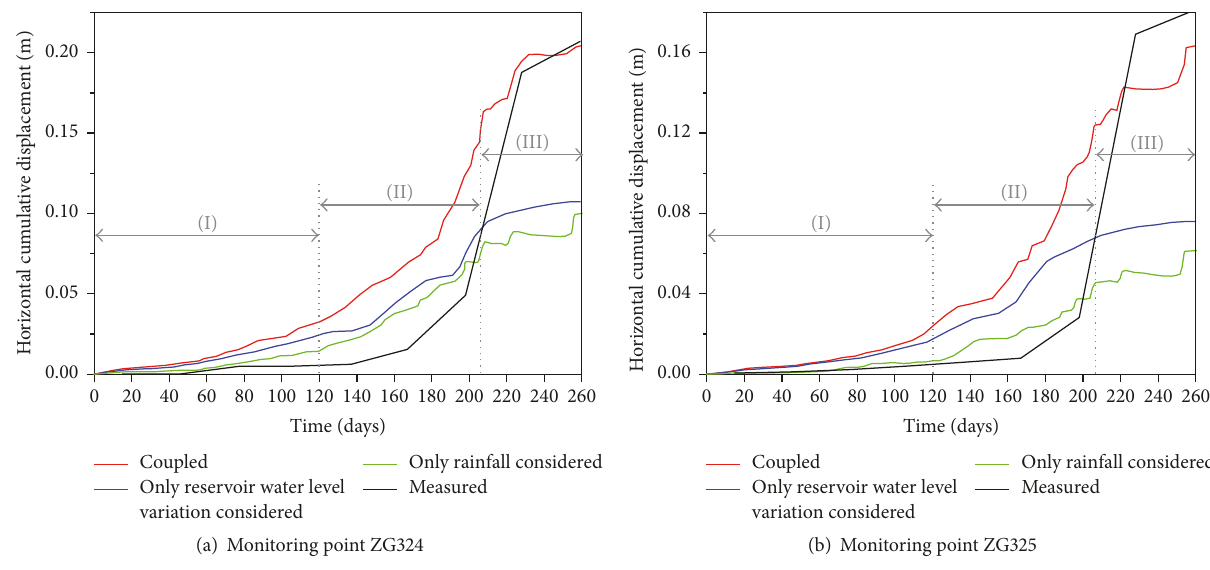
Figure 12: The horizontal cumulative displacement at the points ZG324 and ZG325 from December 7, 2014, to August 18,